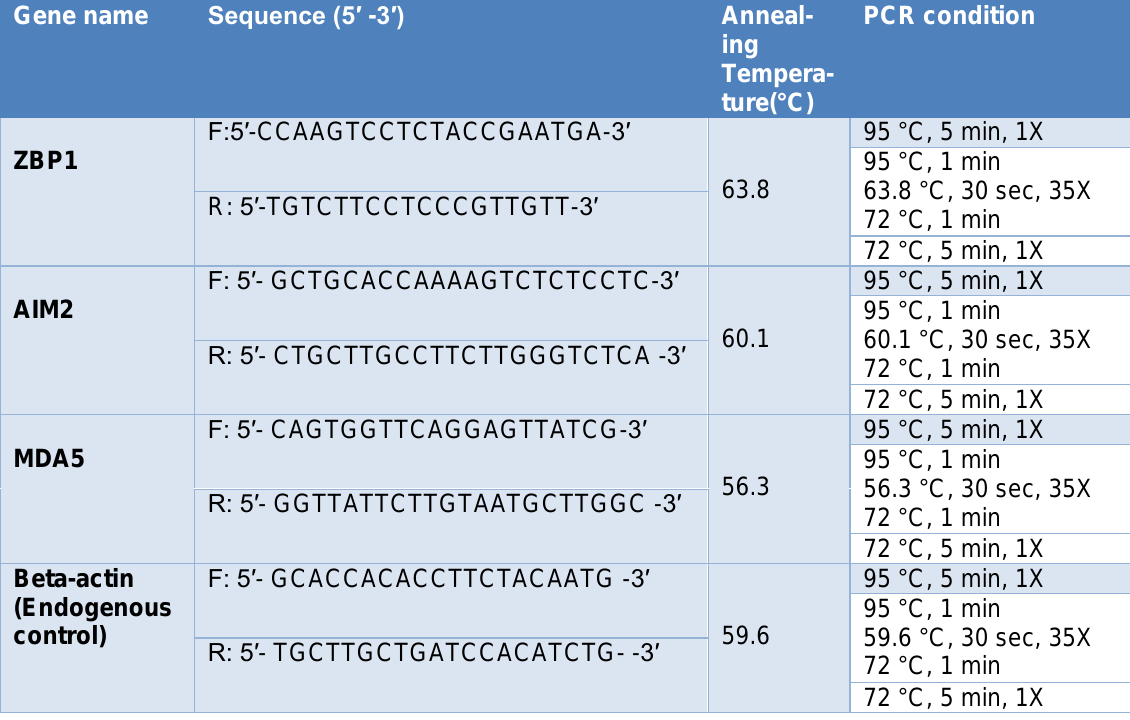
Table 1: The sequences of primers used for RT-qPCR in the study Gene